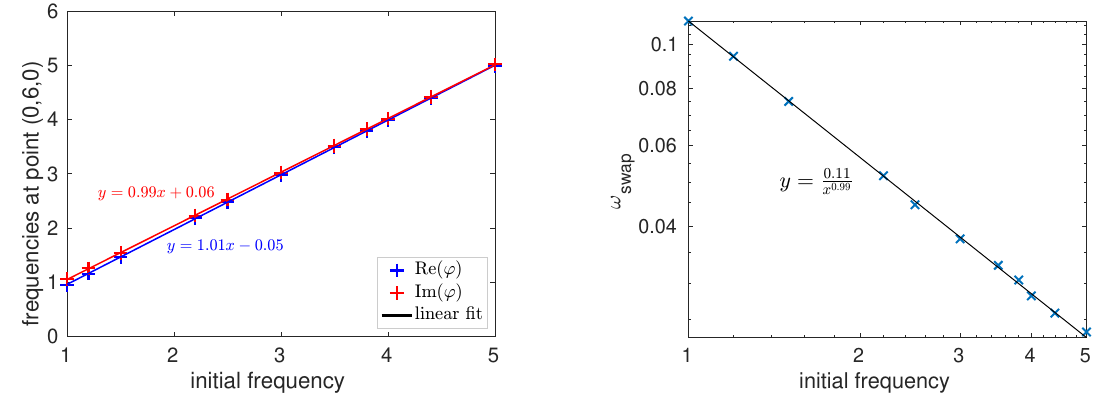
Figure 10 . Dependence of frequencies of the dipole CSQ on the initial frequencies of the constituent Q-balls. These frequencies are obtained by performing Fourier transforms on all the datas from t = 0 to t = 2680 and extracting the dominant peak frequency for each initial frequency. The left plot shows the dominant frequencies of the field components at point (0,6,0). Quasi-linear scaling laws are observed for the dominant frequencies of Re( ϕ ) and Im( ϕ ) on the initial frequencies of Q-balls. The right plot shows the dependence of the charge-swapping frequencies on the initial frequencies of the Q-balls. One can check that the difference between the dominant frequencies of Re( ϕ ) and Im( ϕ ) is to a good approximation the charge swapping frequency of the CSQ.